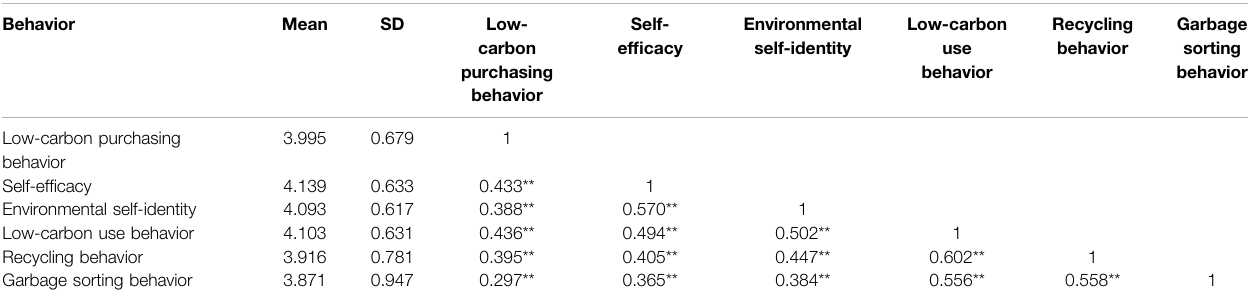
TABLE 3 | Descriptive statistical analysis.